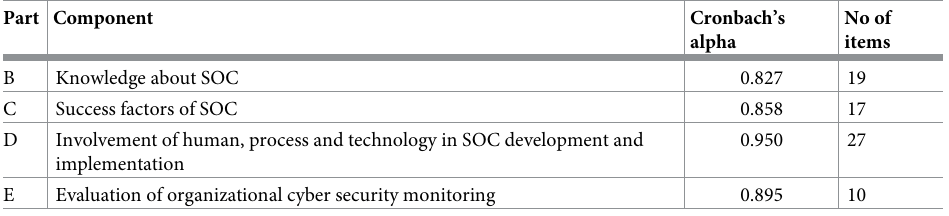
Table 5. Cronbach’s alpha test for each component in the instrument.